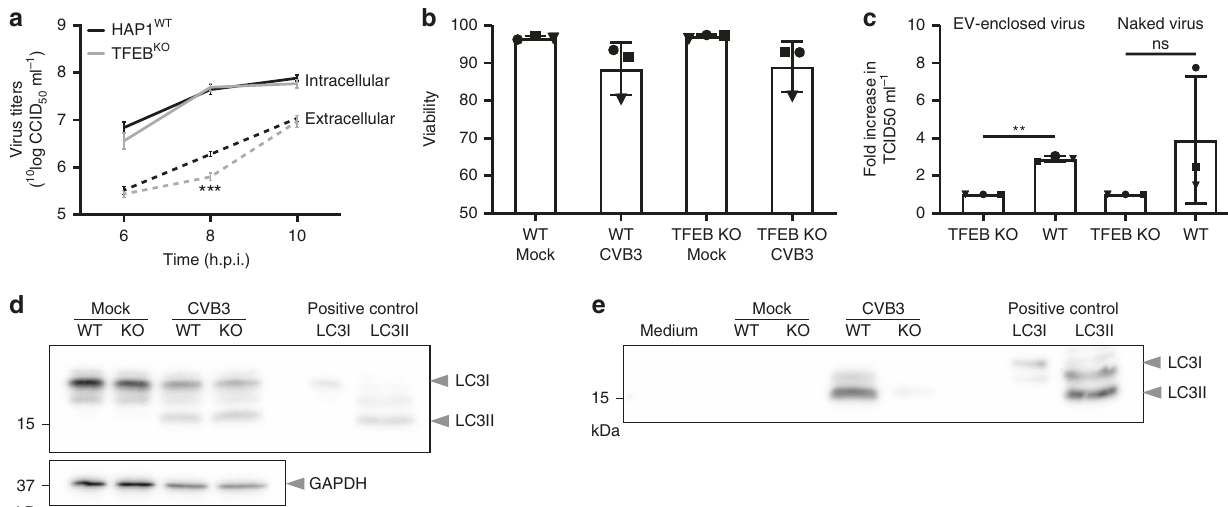
Fig. 5 TFEB promotes non-lytic release of CVB3 in early stages of infection. a Accumulation of extracellular virus is delayed in cells lacking TFEB.